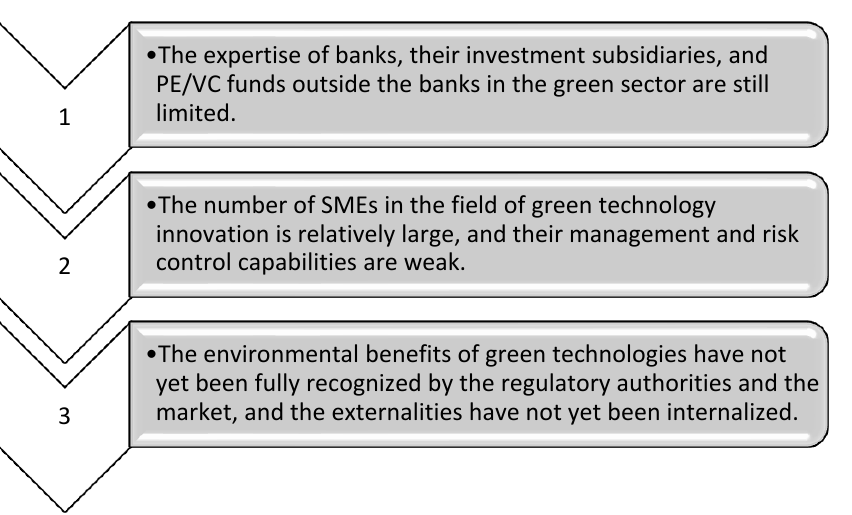
Figure 1. The main causes of problems of investment-lending linkage.